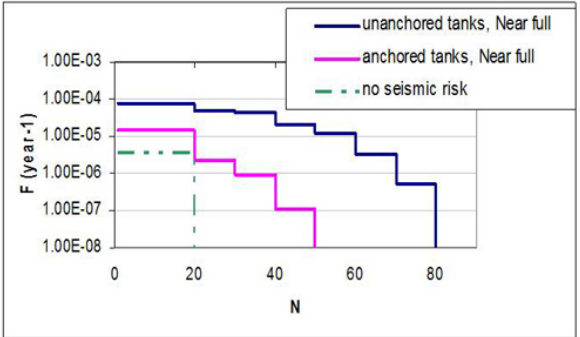
Fig. 2. Societal risk calculated for a storage tank farm with (dashed line) and without (solid lines) considering loss-of-containment events triggered by